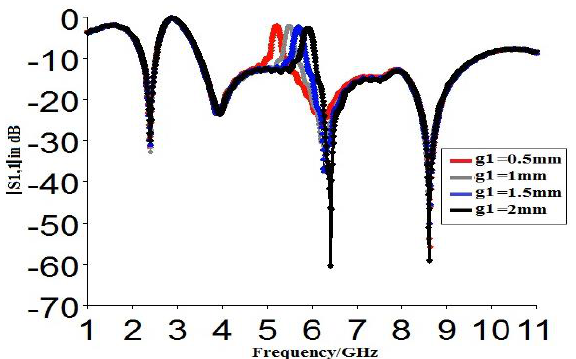
Figure 11: Simulated reflection coefficient for different g